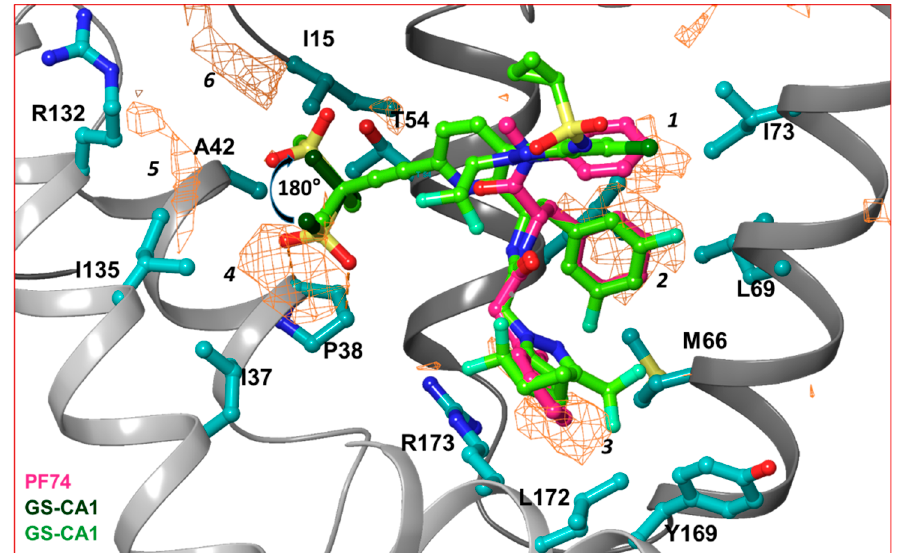
Figure 3. Hydrophobic pockets between two capsid monomers. This figure shows the hydrophobic pockets (orange wire-mesh) present between two capsid monomers of a hexamer. The amino acid residues that contribute in formation of hydrophobic pockets are displayed in ball-and-stick representation. The presence of hydrophobic pockets 4, 5 and 6 suggests that the conformation of methanesulfonyl moieties of GS-CA1 and GS-6207 can assume a conformation that is 180° rotated from previously predicted [65]. Note that hydrophobic pockets 1, 2 and 3 are at a topologically equivalent position to three ring structures of PF74, GS-CA1 or GS-6207.